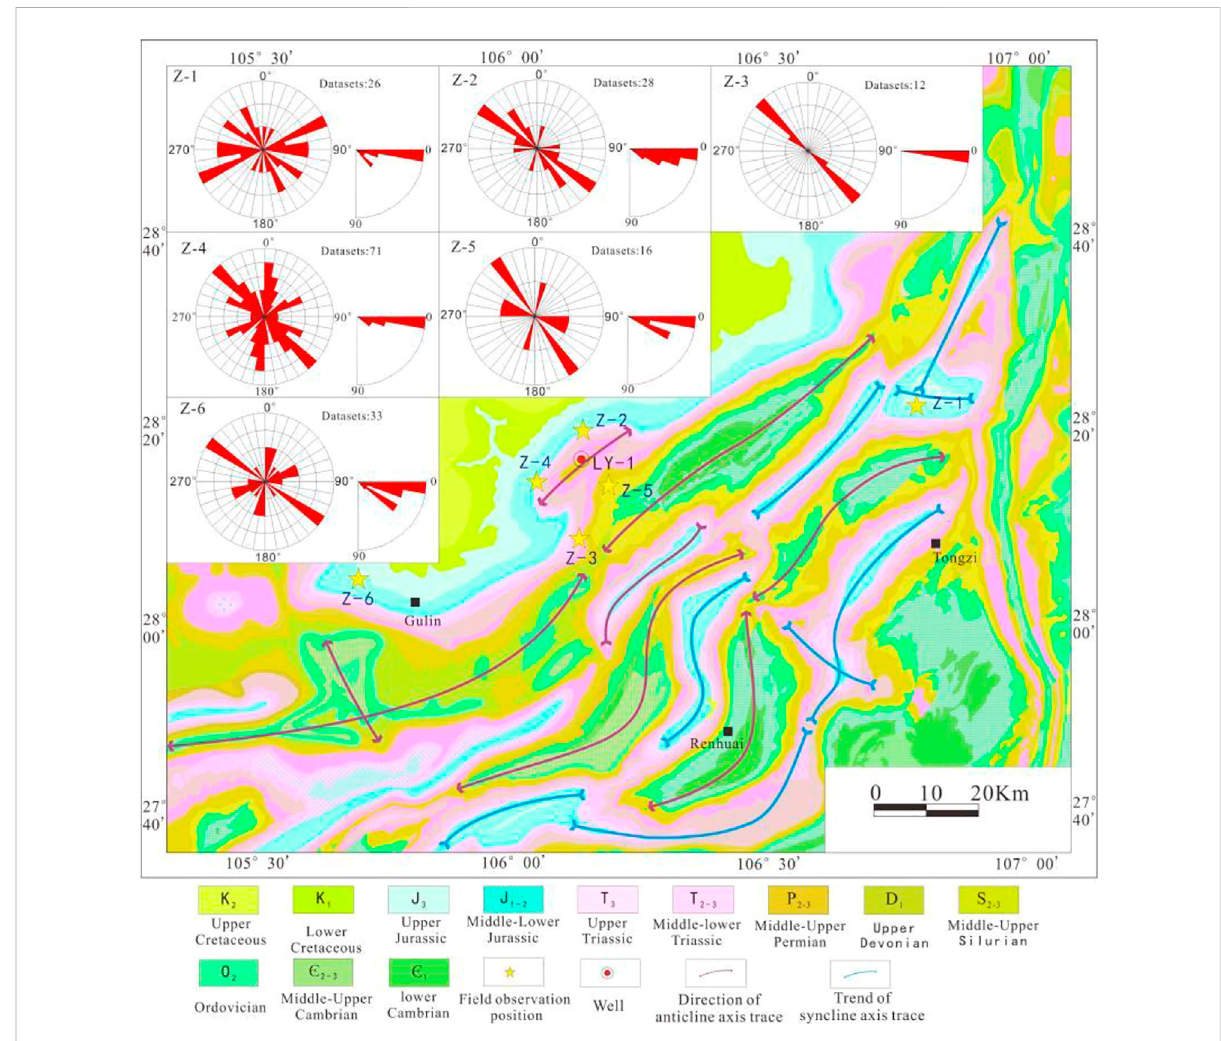
FIGURE 4 Direction of maximum principal stress ( σ 1 ) restored by fault scratches and joints in Lintanchang